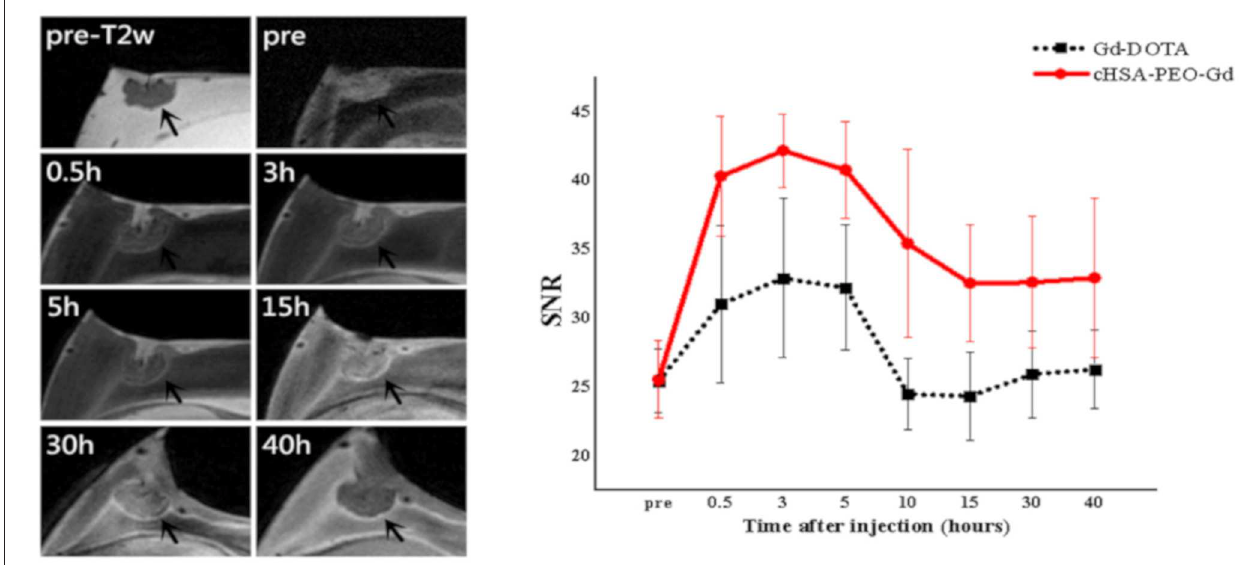
FIGURE 3 | Representative MR images of cHSA-PEO(2000)16-Gd biodistribution in solid tumor (left) and comparison of the SNR (Signal-to-Noise Ratio) of the tumor (right) over the first 40h after systemic injection of cHSA-PEO(2000)16-Gd and Gd-DOTA. This research was originally published under the terms of the CC